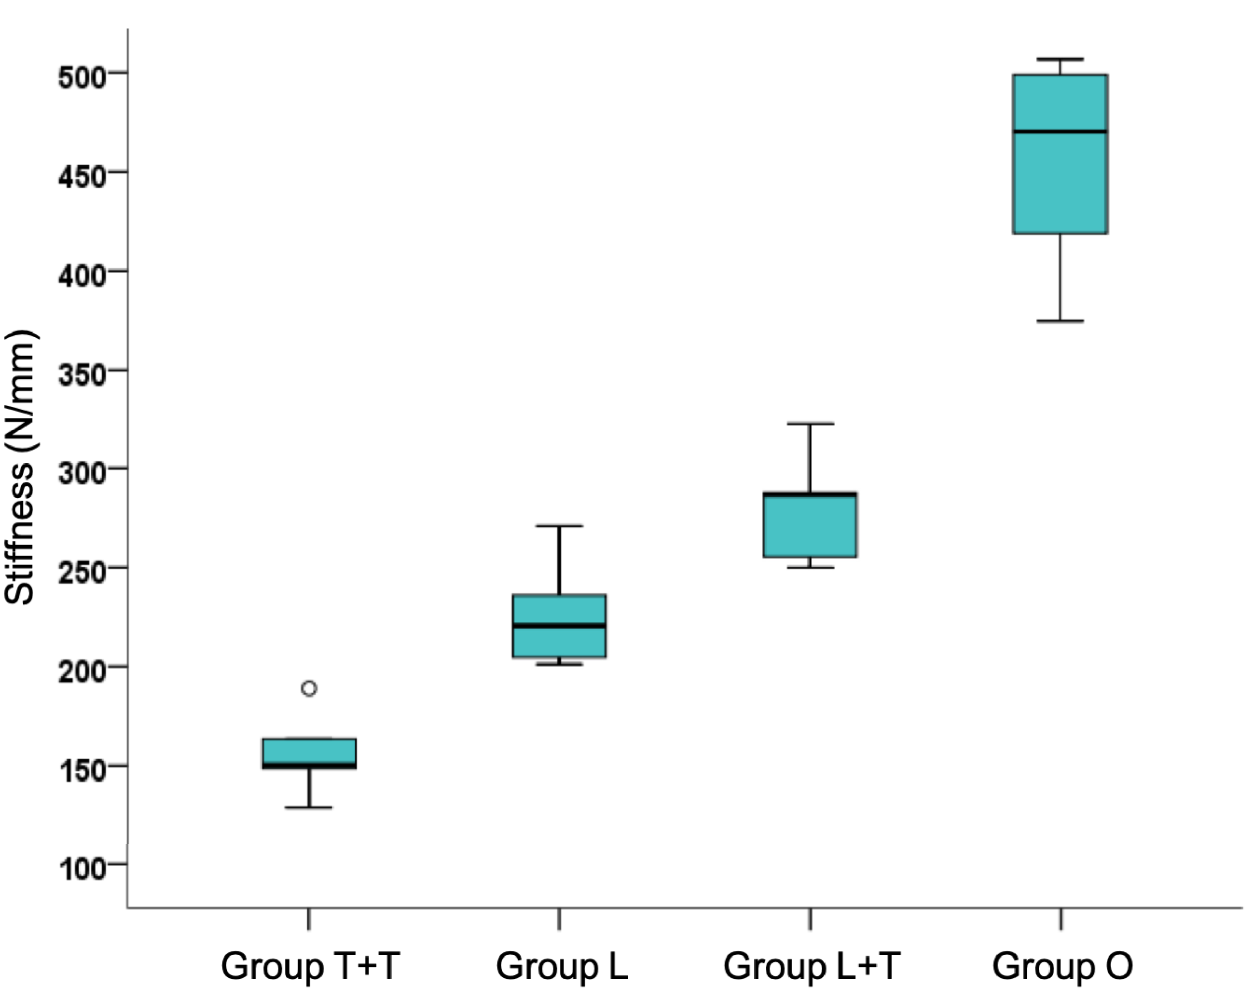
Fig 2. Stiffness (N/mm). Significantly lower stiffness values were seen in the T+T group than in groups L, L+T, and O ( p = 0.01 for all). Group L demonstrated significantly lower stiffness than groups L+T ( p = 0.03) and O ( p = 0.01), and group L+T had significantly lower stiffness than group O ( p = 0.01); the stiffness values can be represented as T+T < L < L+T < O. Group T+T: two non-locking one-third tubular plates positioned at right angles; Group L: locking anatomic plate positioned on the lateral surface of the humerus; Group L+T: two perpendicular plates, one locking and one one-third tubular; Group O: